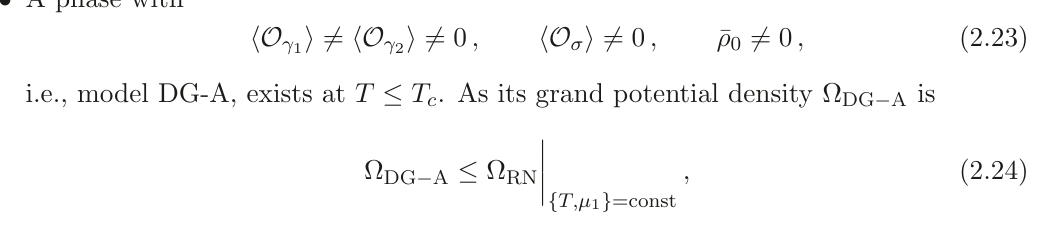
as a function of T/µ 1 in model DG-A (green curve) hO γ 1 i as a function of T/µ 1 }